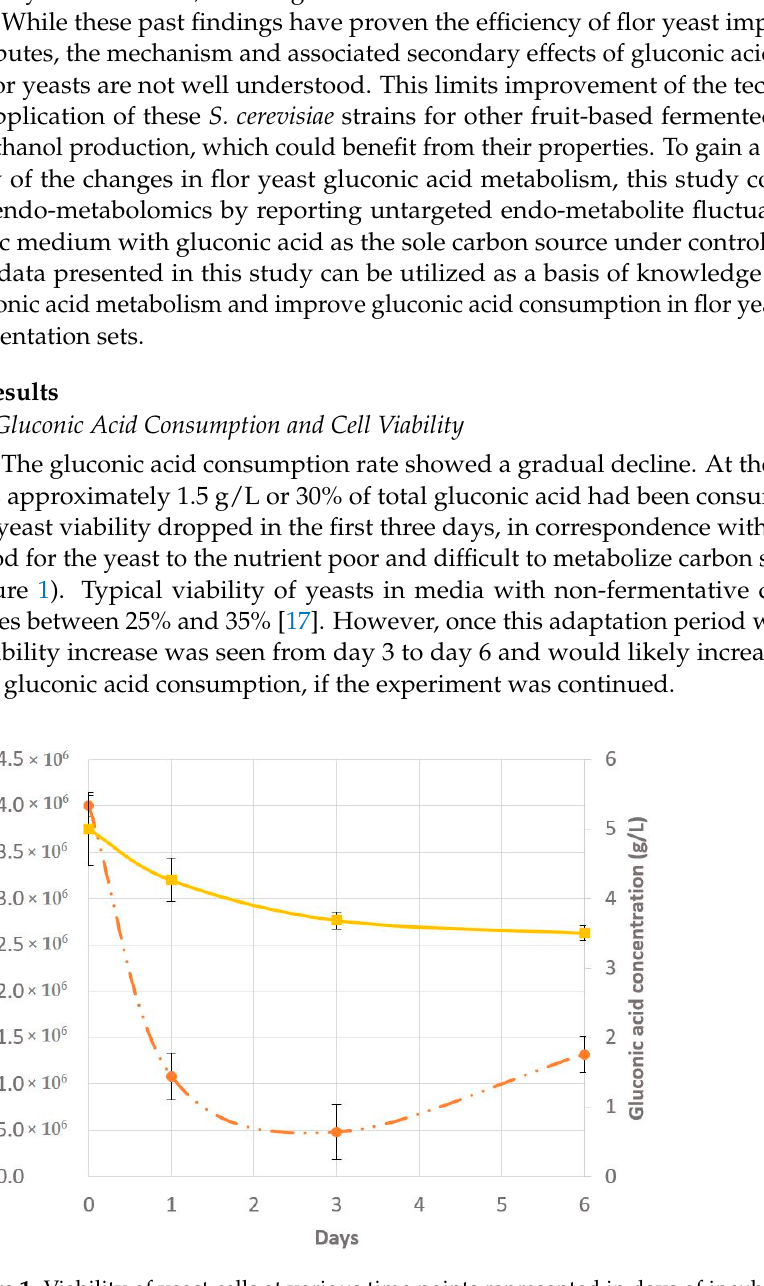
Figure 1. Viability of yeast cells at various time points represented in days of incubation in gluconic acid medium (orange dotted line). Gluconic acid concentration (g/L) in the media at various time points represented in days of incubation in gluconic acid medium (yellow solid line).